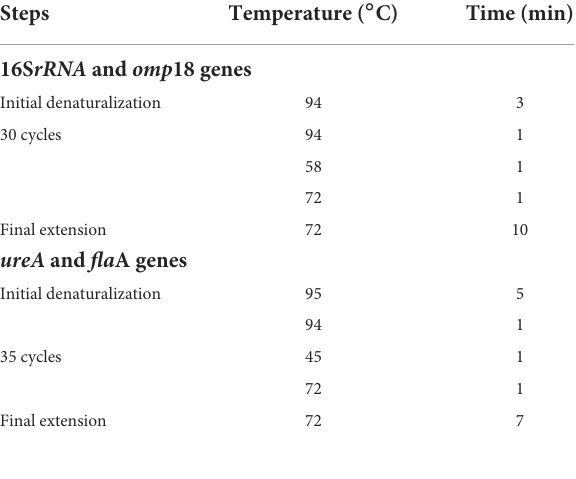
TABLE 3 Protocols of PCR amplification for Helicobacter pylori